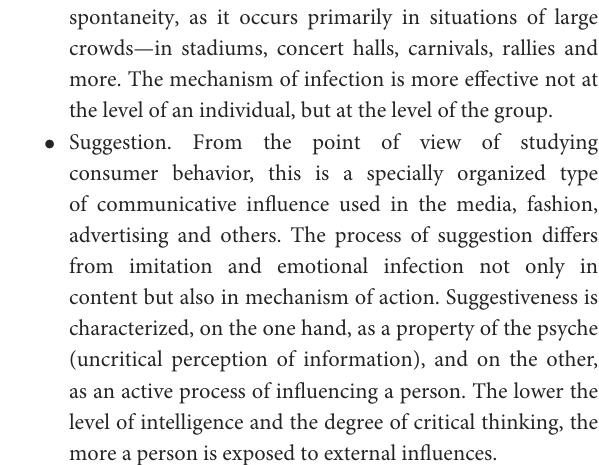
FIGURE5 Stages of information processing according to the model of William McGeer.